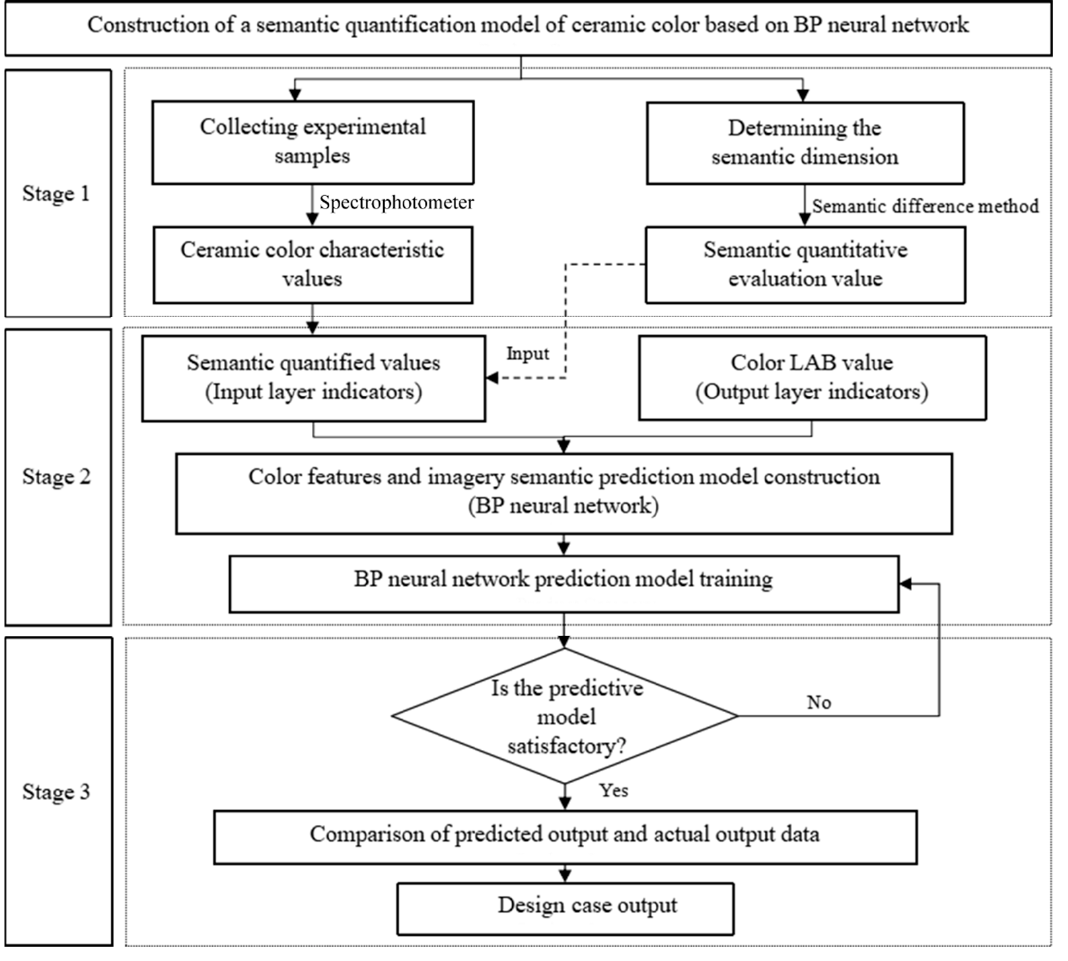
Figure 1. Flow chart of the study.